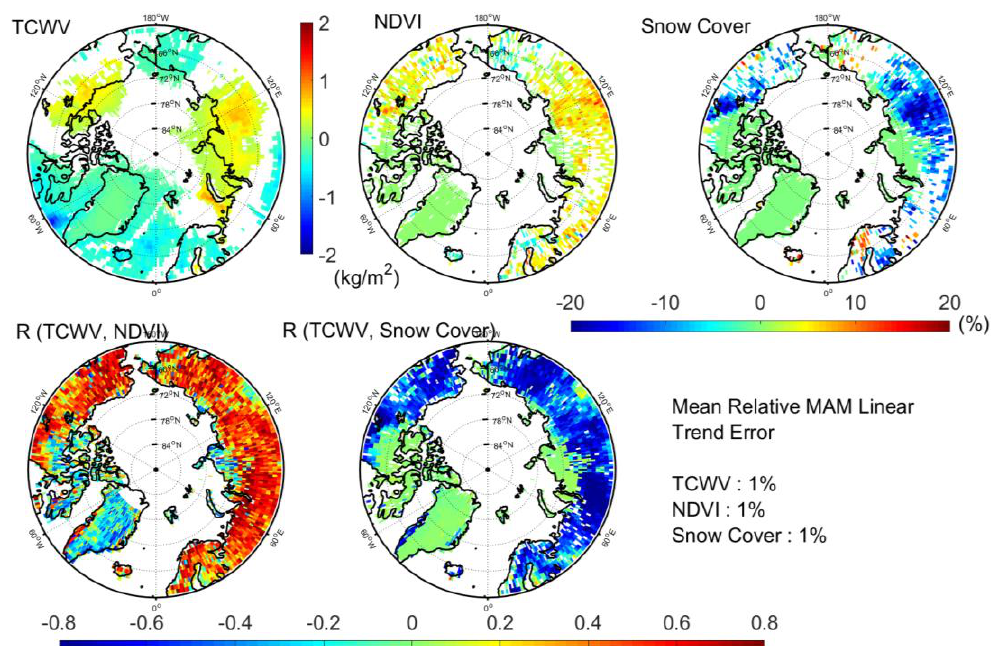
Figure 4. (Upper plots) Absolute trends in MAM of TCWV, normalized differential vegetation index (NDVI), and snow cover from left to right, respectively. Lower plots: Correlation coefficients in MAM of ( left ) TCWV with NDVI and ( right ) TCWV with snow cover for the whole 15 years of data. Note that TCWV trends are in kg/m 2 /decade, and NDVI and snow cover use the same colour bar ( bottom ); their trends are in %/decade. Both correlation maps use the colour bar at the bottom. Only statistically significant trends at the 95% confidence level based on a Student’s t test are shown. Pixels with missing data or not significant trends at the 95% confidence level are in white.